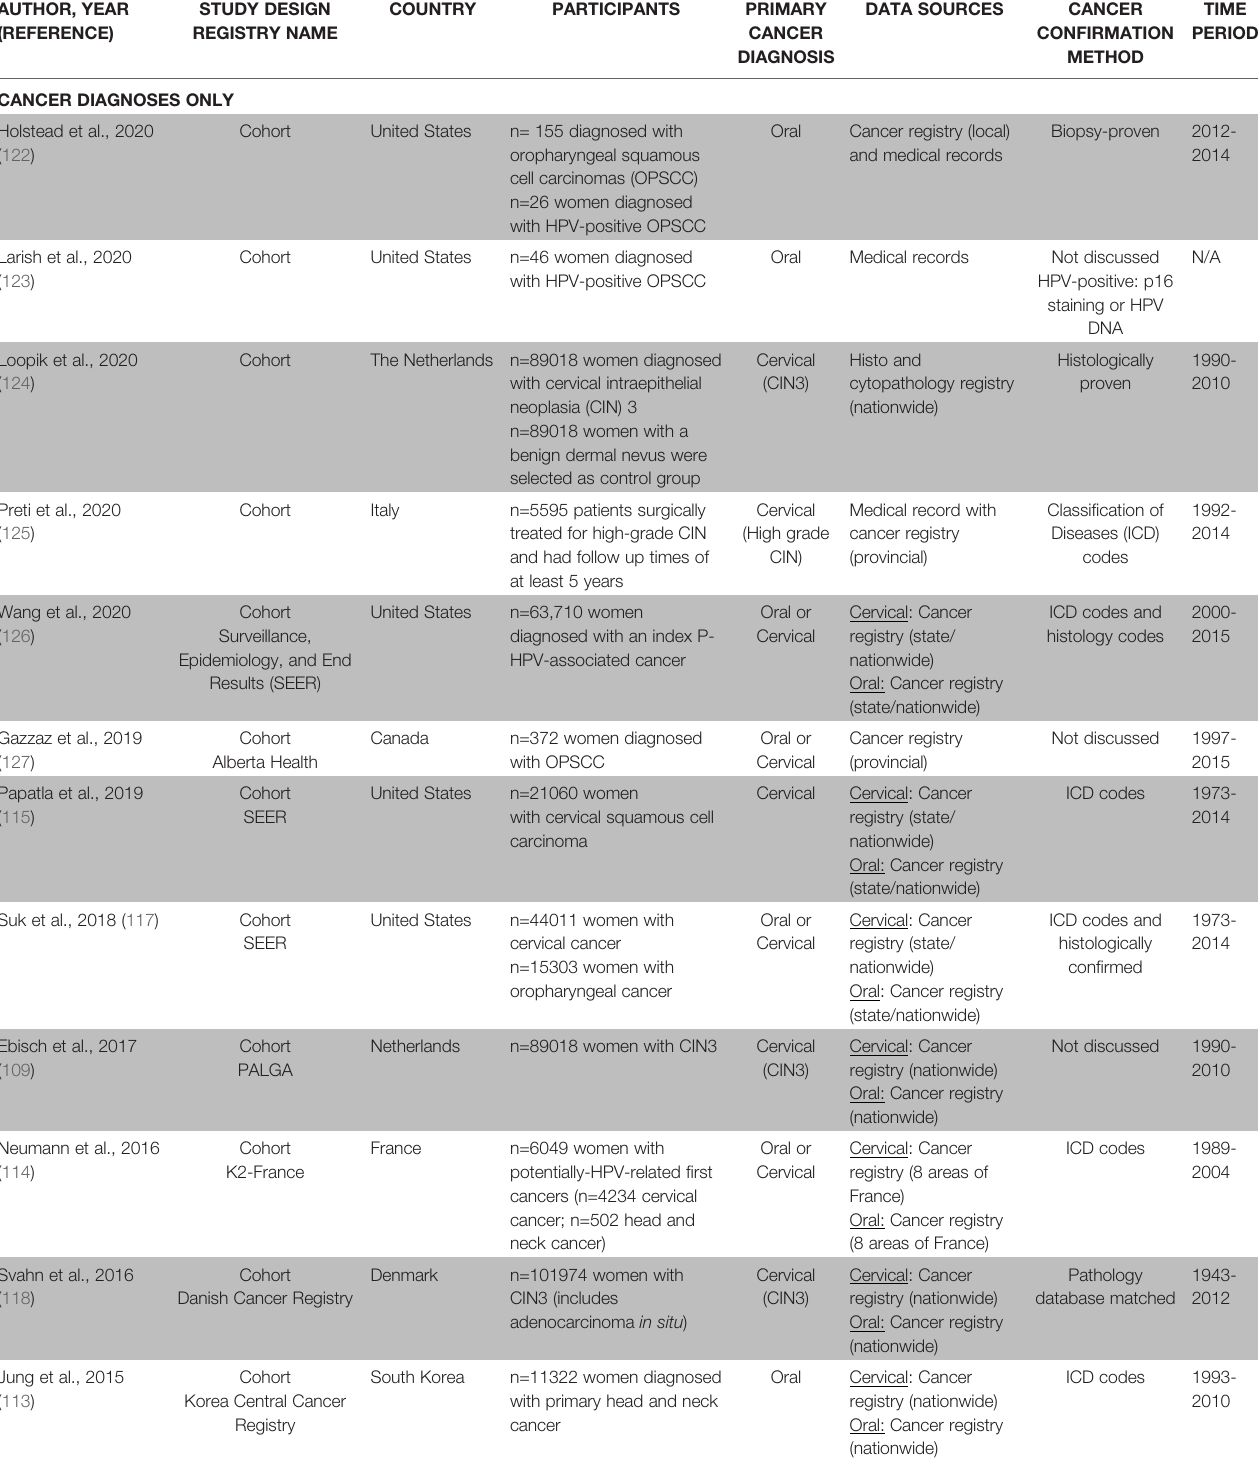
TABLE 2C | Description of methodology used in oral-cervical human papillomavirus (HPV)-related cancer diagnoses only papers